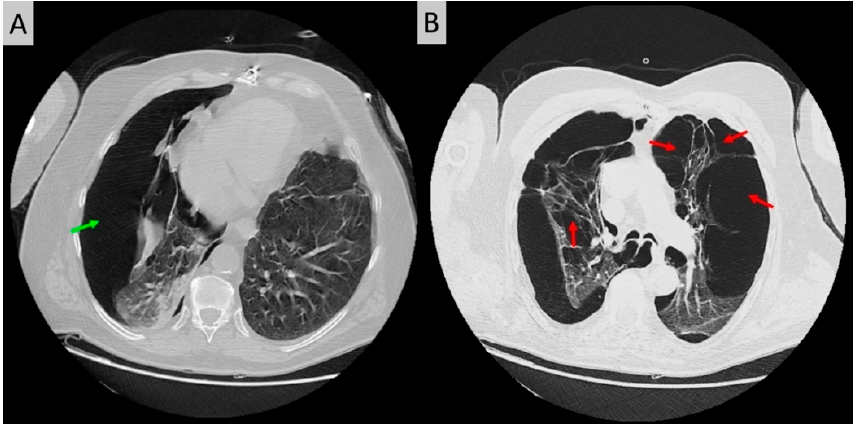
Figure 2. Transverse unenhanced chest CT scan revealing a large right-sided pneumothorax (green arrow) with compressive atelectasis of the right lung and emphysematous changes in both lungs ( A ); multiple bullae due to the underlying emphysema were noted in the left (red arrows) as well as the right lung in addition to the right-sided pneumothorax ( B ).